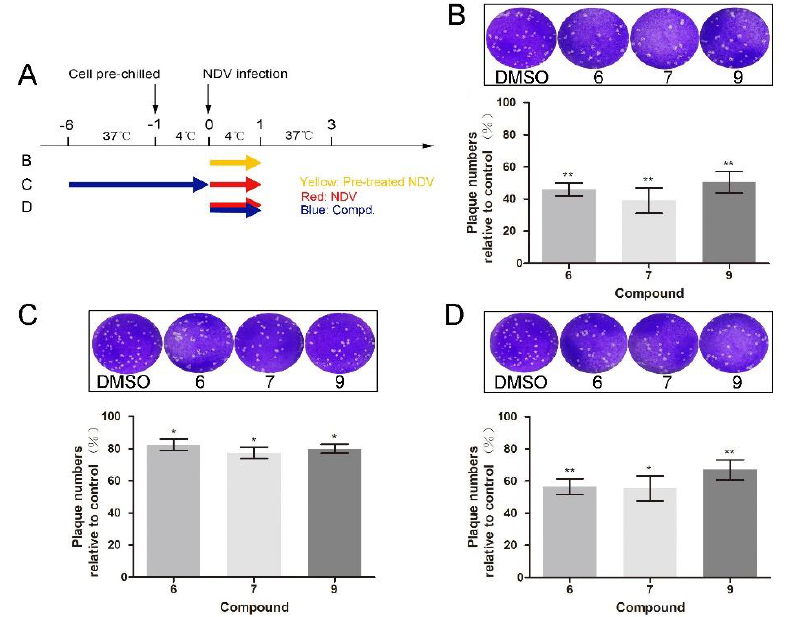
Figure 3. 1-Formyl- β -carboline derivatives inhibit NDV adsorption. ( A ) Compound treatment and NDV infection schemes in the adsorption assay. ( B – D ) After infection with pre-treated or untreated NDV (100 PFU), DF-1 cells were covered with a medium containing methylcellulose. At 72 h post- infection, the virus yield was analyzed. Dynasore (100 μM) was used as a positive control. The data represent the mean ± SD of three independent experiments. The statistical significance was analyzed using a two-tailed Student ’s t -test: * p < 0.05; ** p < 0.01.